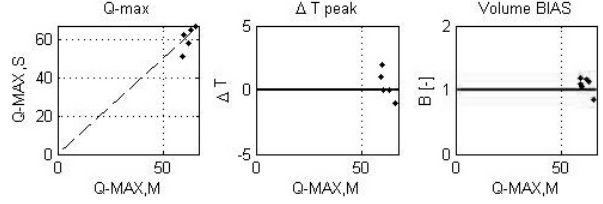
Fig. 4. Model efficiencies for calibration peak flows separated on the basis of the one-year recurrence interval at the Vent – Venterache gauge (165km 2 ). Left: measured peak flow ( Q MAX , M [m 3 /s]) vs. simulated peak flow ( Q MAX , S [m 3 /s]); middle: temporal shift of the peak flow ( 1T [h]) vs. ( Q MAX , M [m 3 /s]); right: bias of the events discharge volume ( B [-]) vs. ( Q MAX , M [m 3 /s]).